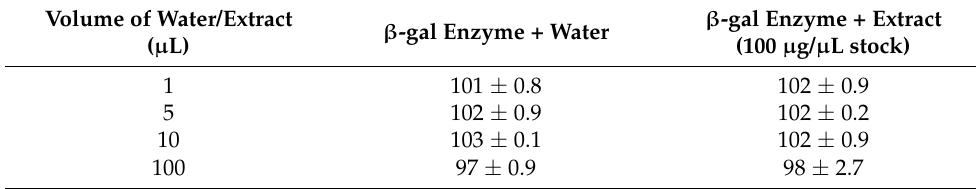
Table 2. β -galactosidase Activity.